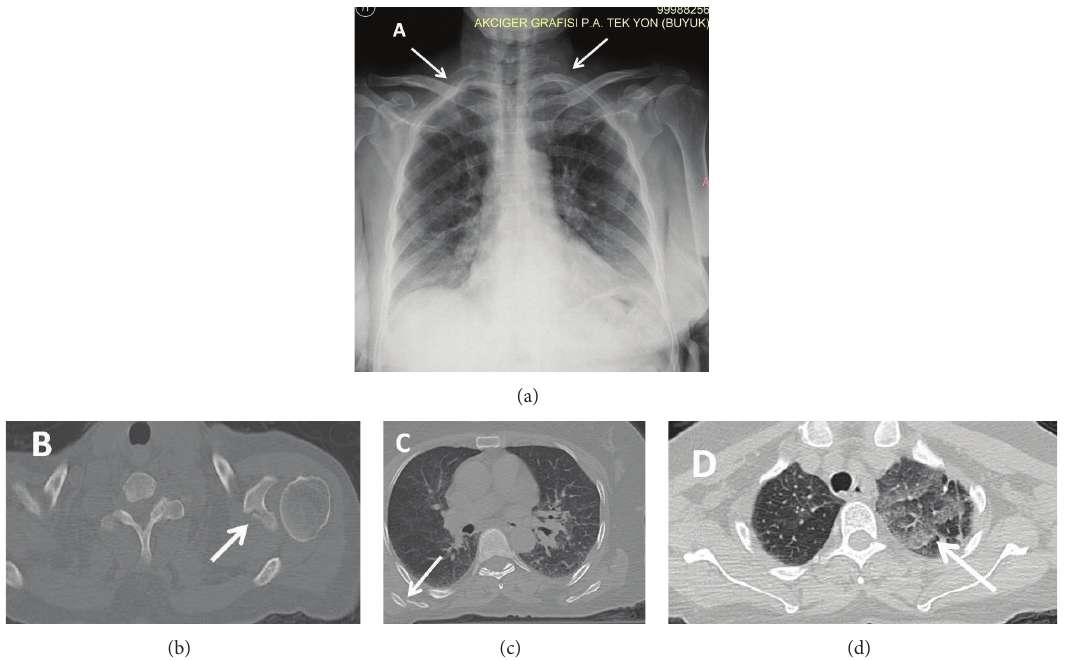
Figure 1: (a) Bilateral first rib fractures (white arrows). (b) Left scapular glenoid fracture (white arrow). (c) Right scapular body fracture (white arrow). (d) Pulmonary contusion (white